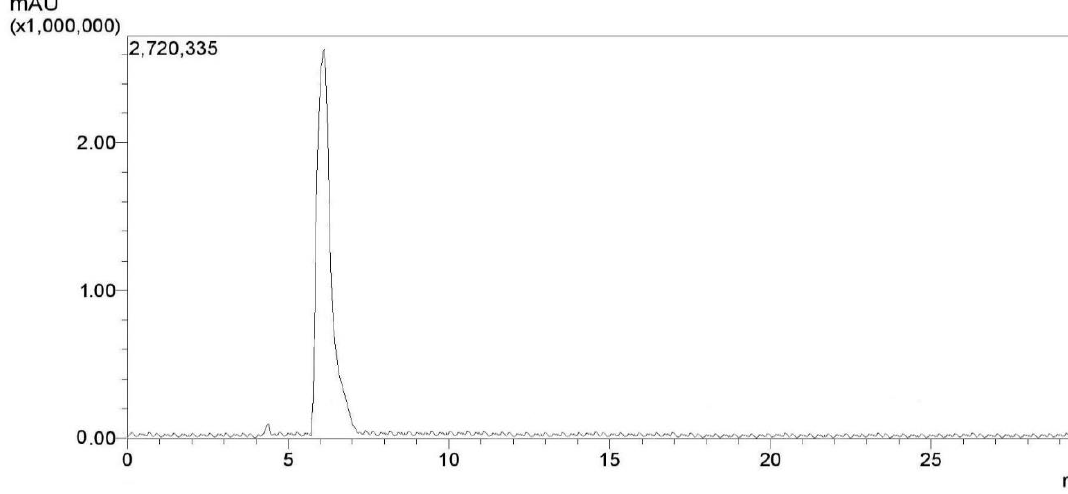
Table 1. The obtained elemental analysis data of the synthesized N